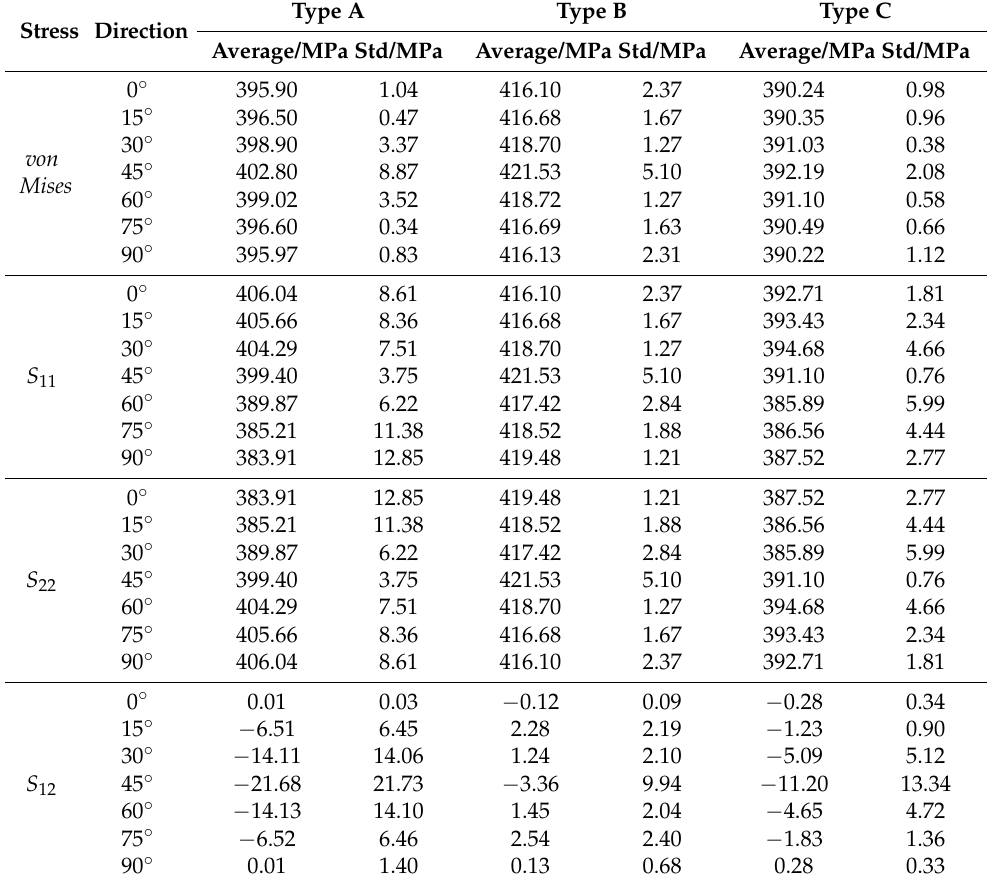
Table 2. Stress distribution in different directions in the gauge area. Type Stress Direction